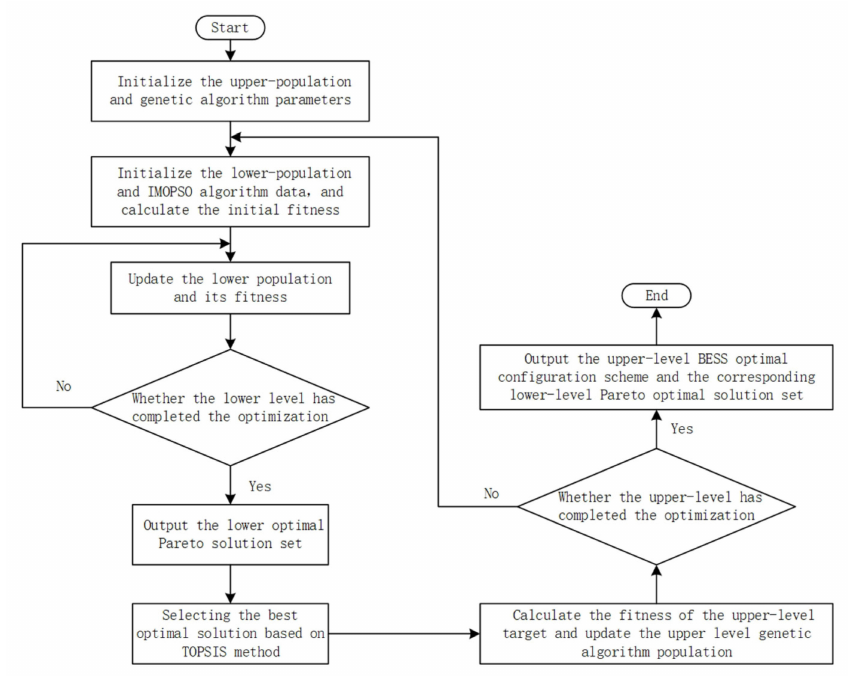
Figure 5. Calculation